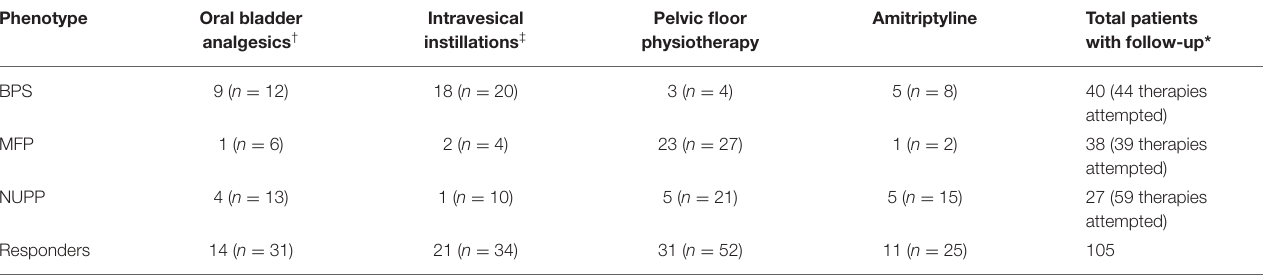
TABLE 3 | Responders to typical IC/BPS therapies by phenotypic